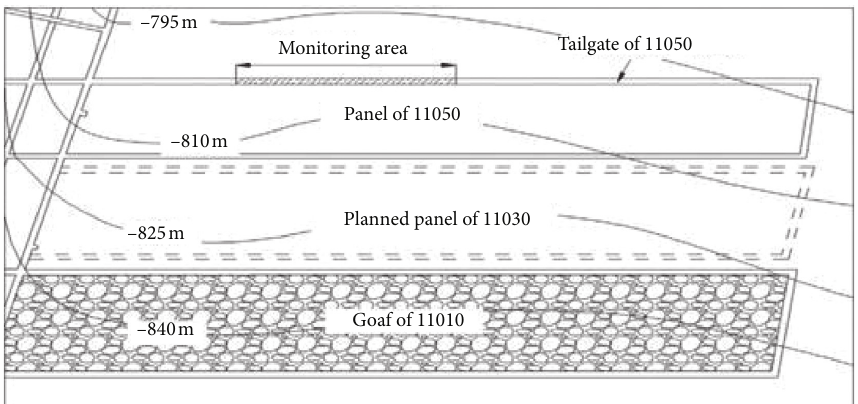
Figure 1: Plan view of local panel layout.